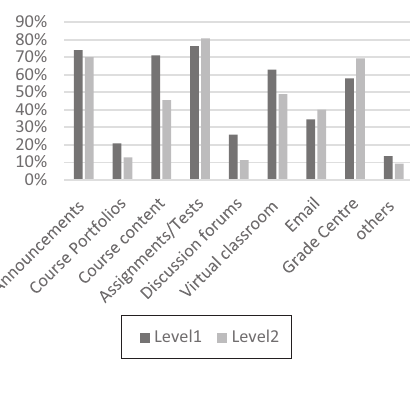
Figure 3. Results of part 2